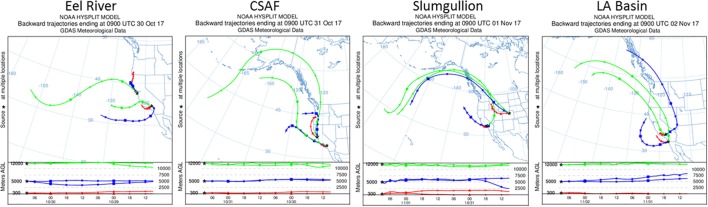
HYSPLIT kinematic back trajectories model air transport history for flights 30 Oct to 2 Nov 2017.